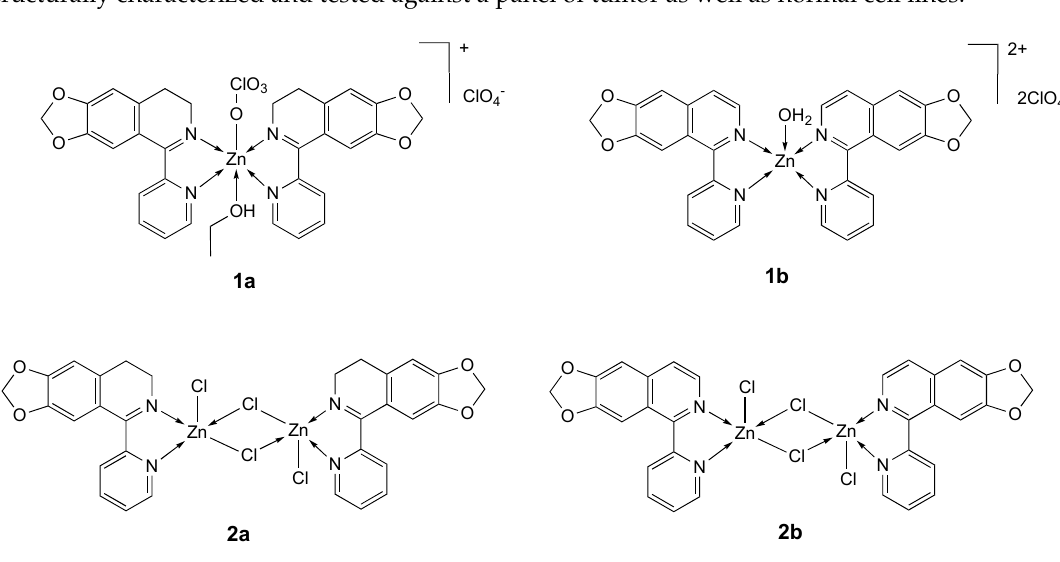
Figure 1. Structure of the zinc complexes 1a , 1b and 2a , 2b .